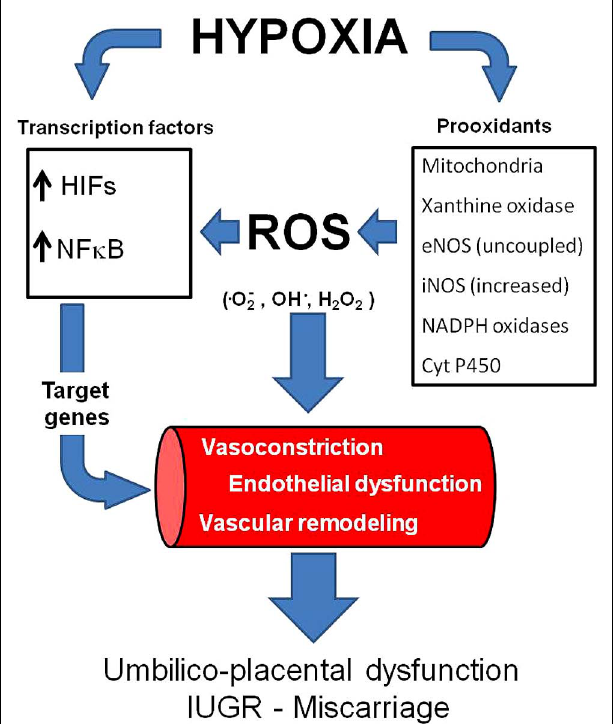
FIGURE 1 |Vascular responses induced by hypoxia and oxidative stress. Hypoxia may increase ROS generation and induce (activate) transcription factors such as HIFs and NF κ B. Consequently, the transcription of several genes is activated, inducing vasoconstriction and vascular remodeling. In addition, hypoxia and oxidative stress may induce endothelial dysfunction. All of the above impair vasodilatation capacity in the umbilico-placental vasculature and increases the risk of IUGR and miscarriage. ROS,: reactive oxygen species; HIFs, hypoxia inducible factors;, NF κ B, nuclear factor-kappa